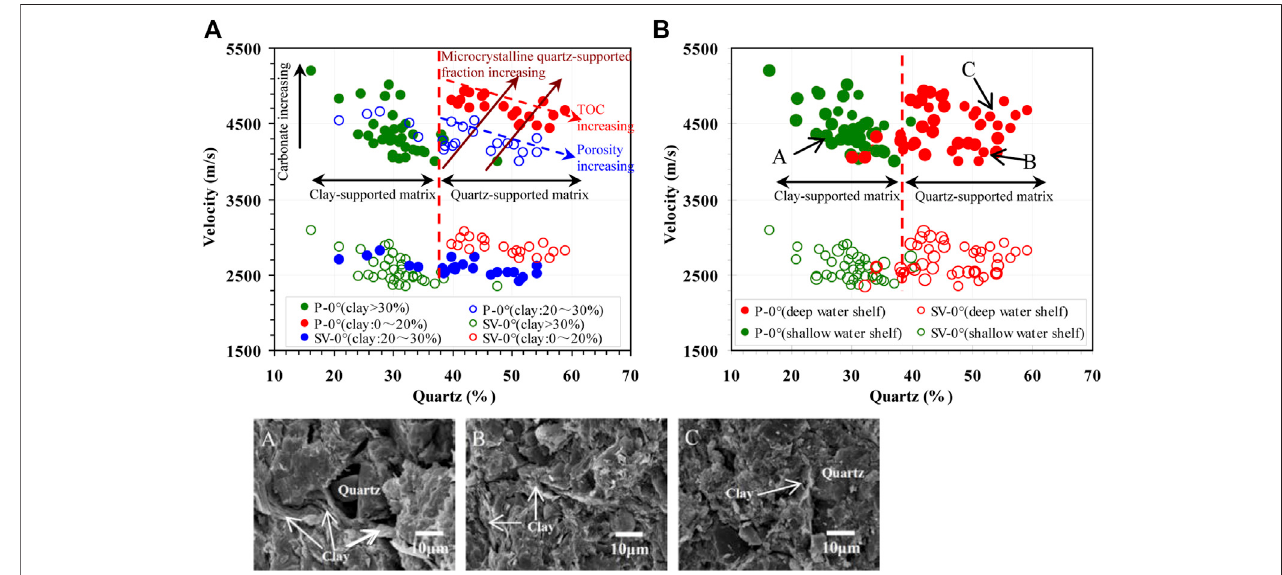
FIGURE6 | Effect ofmicrotexturevariations onvelocityofshale samples. (A) and (B) Velocityvariations withquartzcontent, where data aresorted byclay content and sedimentary circumstance, respectively (A) SEM photomicrographs of clay as load-bearing grains (Sample C24; Clay: 43.7%; Quartz: 26%; TOC: 0.92%) (B) SEM photomicrographs of clay and quartz jointly as load-bearing grains (Sample C52; Clay: 32.4%; Quartz: 51.2%; TOC: 6.26%) (C) SEM photomicrographs of quartz as load-bearing grains (Sample C33; Clay: 17.5%; Quartz: 55.3%; TOC: 4.7%).